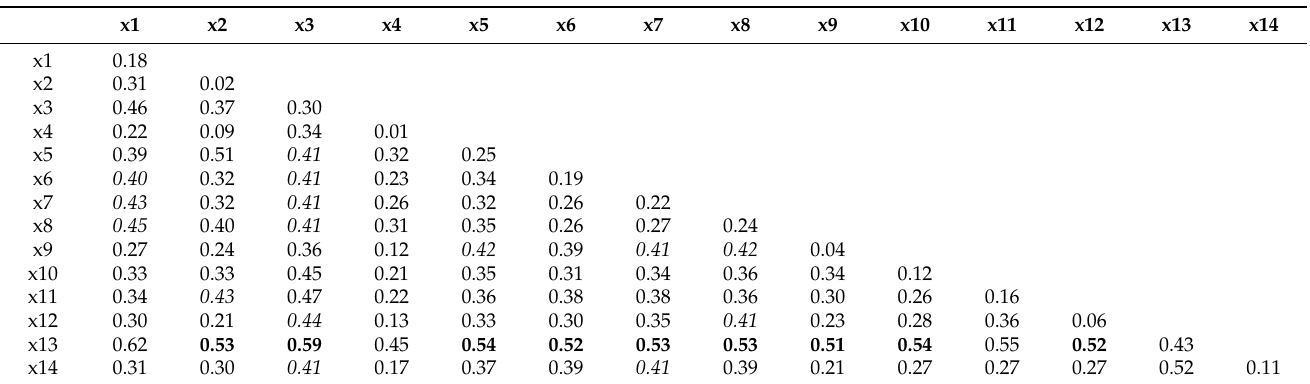
Table 4. Interactive detection results.